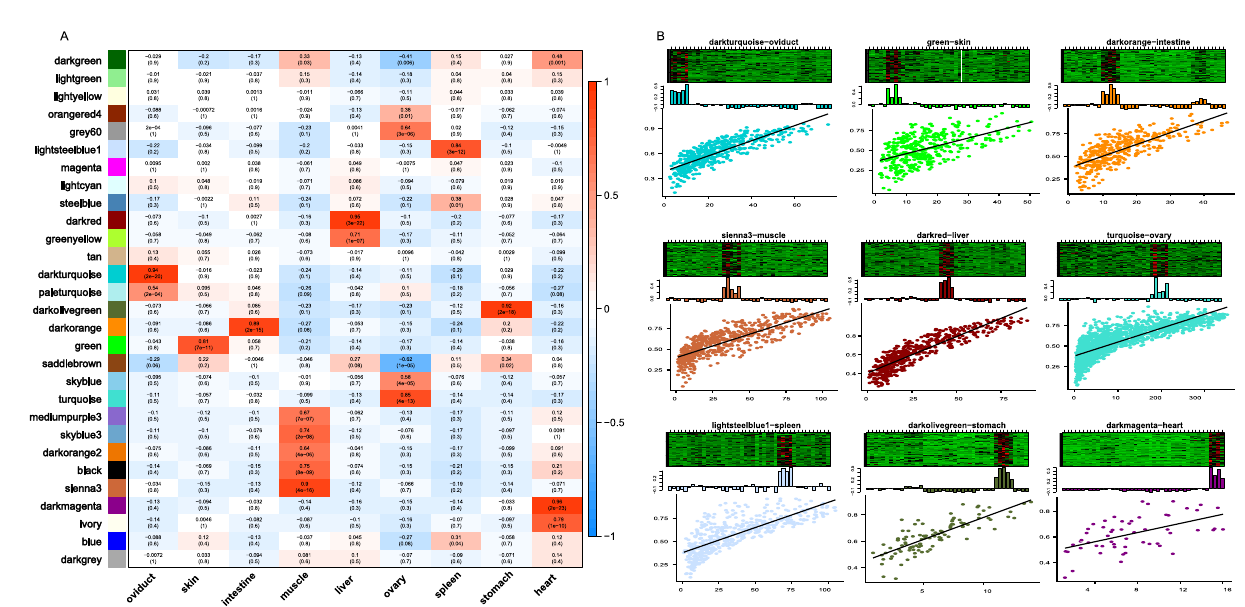
Figure 2. Analysis of gene co-expression modules. ( A ) Heatmap illuminates the association between modules and tissues. Each row corresponds to a module. Each column corresponds to a specific tissue. The color of each cell at the row-column intersection indicates the correlation coefficient between the module and the tissue. Red means significant correlation and blue means no significant correlation. ( B ) The internal situation of each module significantly related to the tissue (module − trait relationship > 0.8). The heatmap and histogram show the expression of all the genes belong to this module in each sample. The point graph visually shows the correlation between the module and tissue. (WGCNA_1.69: https:// horva th. genet ics. ucla. edu/ html/ Coexp ressi onNet work/ Rpack ages/ WGCNA/ WGCNA_1. 69- 81. tar.